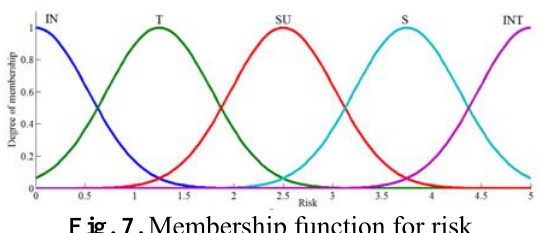
Fig. 5. Membership function for probability of occurrence